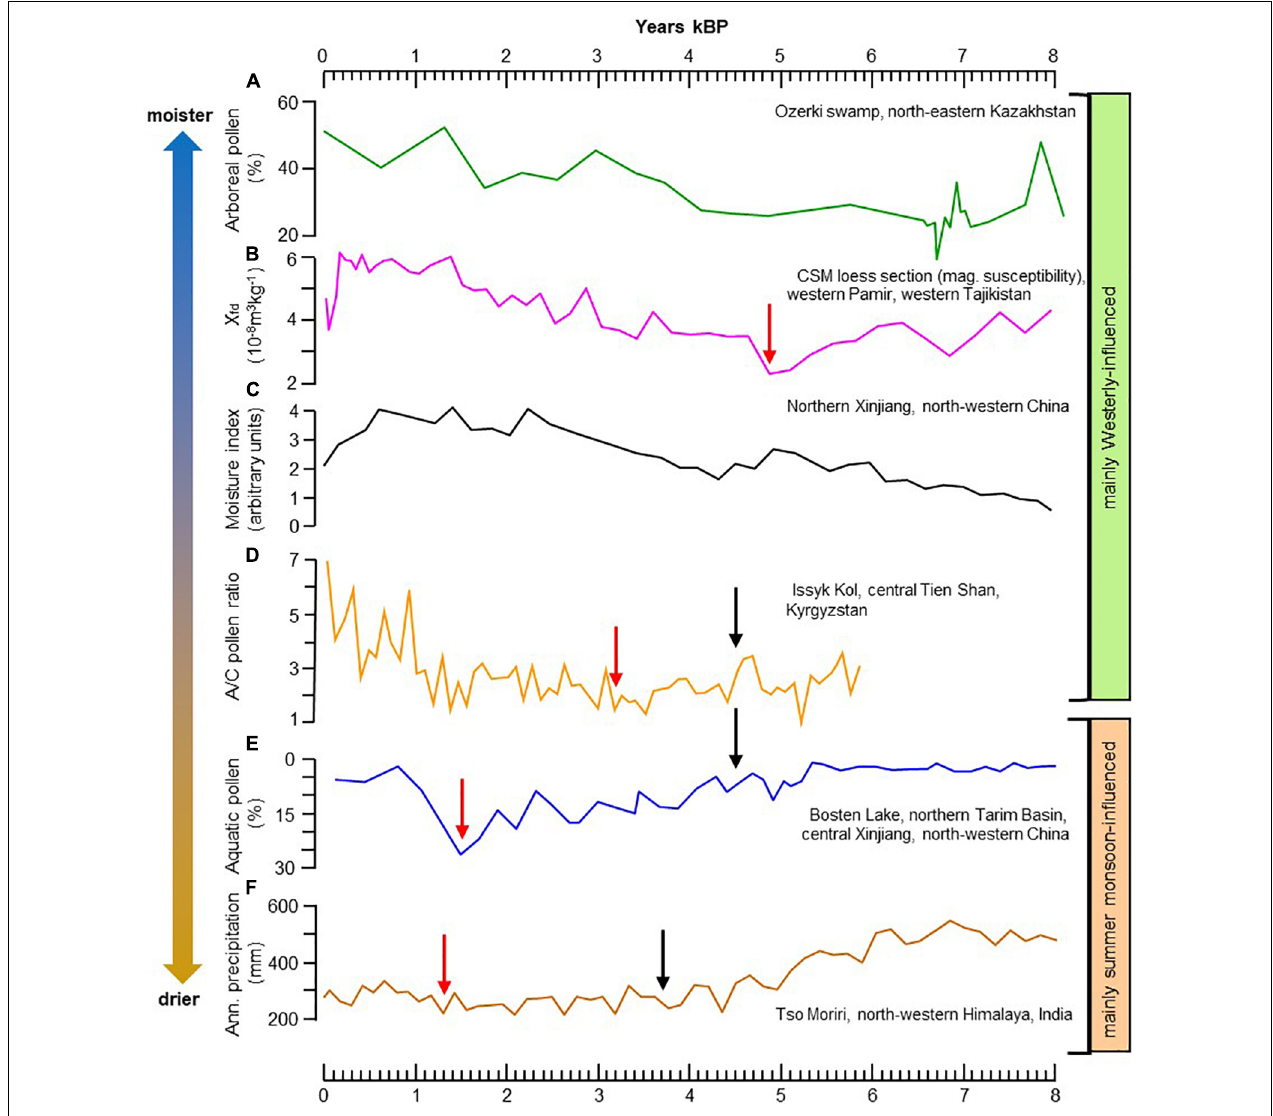
FIGURE 3 | Representative moisture records from Westerly and summer monsoon-controlled regions. (A) Tarasov et al., 1997; (B) Gao et al., 2019; (C) Ran and Feng, 2013; (D) Leroy, 2022; (E) Tarasov et al., 2019; (F) Leipe et al., 2014a. Red arrows mark the transition from summer monsoon-dominated to a Westerly-dominated moisture availability. Records without arrows represent regions that were consistently influenced by Westerly precipitation. Black arrows indicate human impacts in palaeoenvironment record for Central Tien Shan, Xinjiang and Western Himalayan